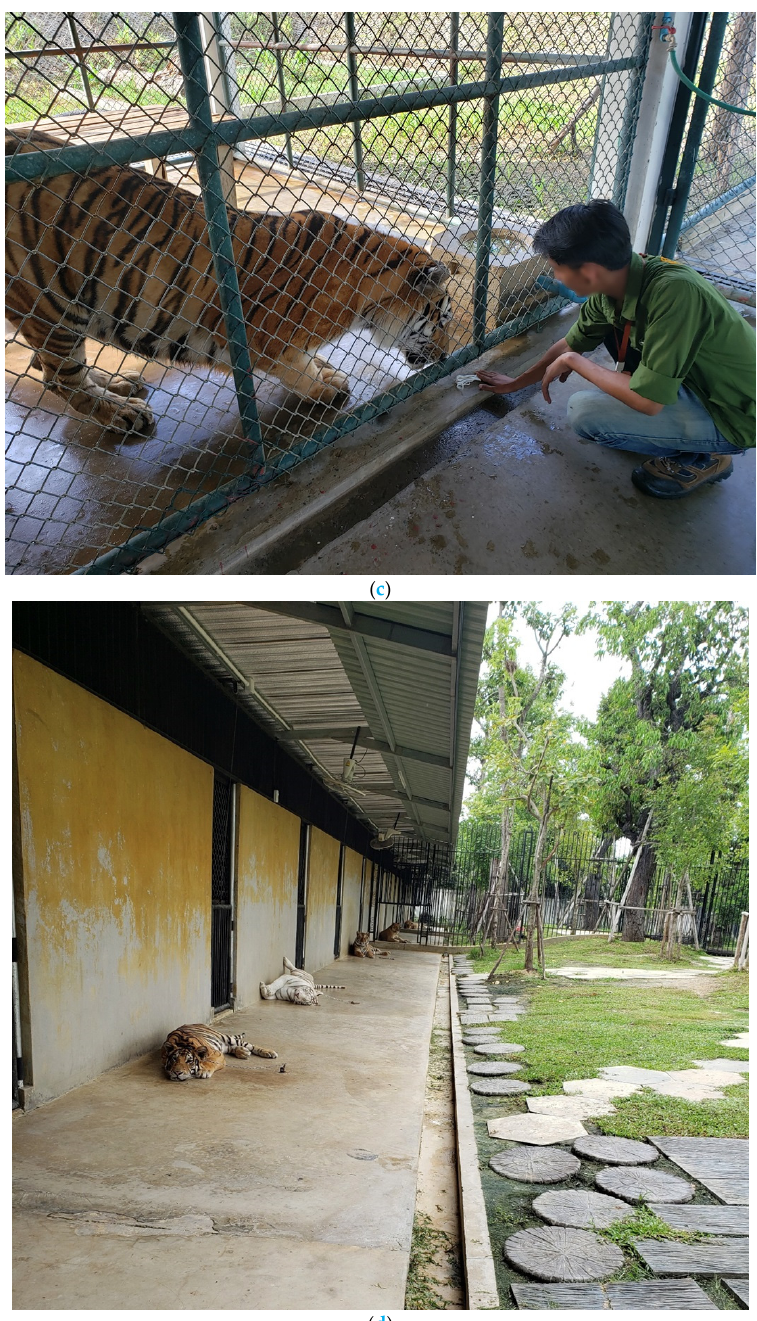
Figure 2. ( a ): An adult tiger and his caregiver are waiting for the tourists. The tiger is not chained and is able to move freely within the enclosure. This tourist enclosure has a small pool, toys, and varying terrain. The tiger’s caregiver is holding a foot-long bamboo stick (behind his back) which is a bridging stimulus used for training. ( b ): The tiger cubs are housed separately from the adult tigers. They are monitored with a security camera. The tourists can be in direct contact with the cubs under supervision of caregivers during the operational hours. Any cubs who express any stress behaviors would be returned and replaced with a new cub. ( c ): The caregiver offers a string toy to the retired tiger housed in an individual pen. Behind the pen is a common playground where the tiger has access to a pool, toys, hidden treats, and trees to encourage natural behaviors. Each retired tiger spends a few hours or more per day in the common playground. ( d ): The tigers are chained with an approximately three feet-long chains while waiting for the tourists and are housed in the pen adjacent to their chain